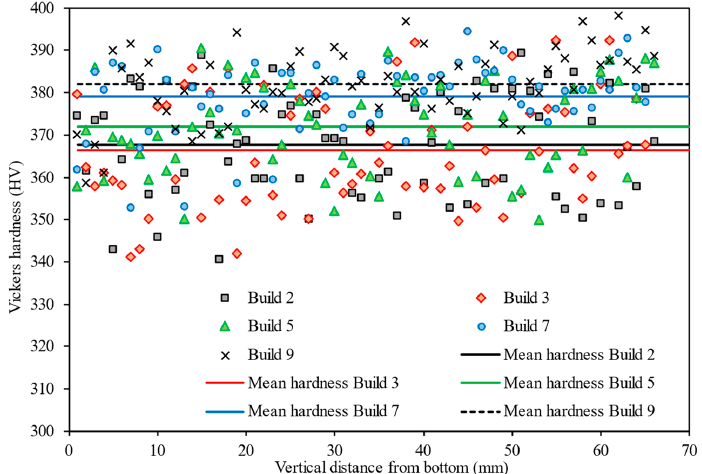
Figure 5. Vickers hardness measured as a function of height from the substrate for build cycles 2, 3, 5, 7, and 9. The solid lines represent the mean hardness of each component.